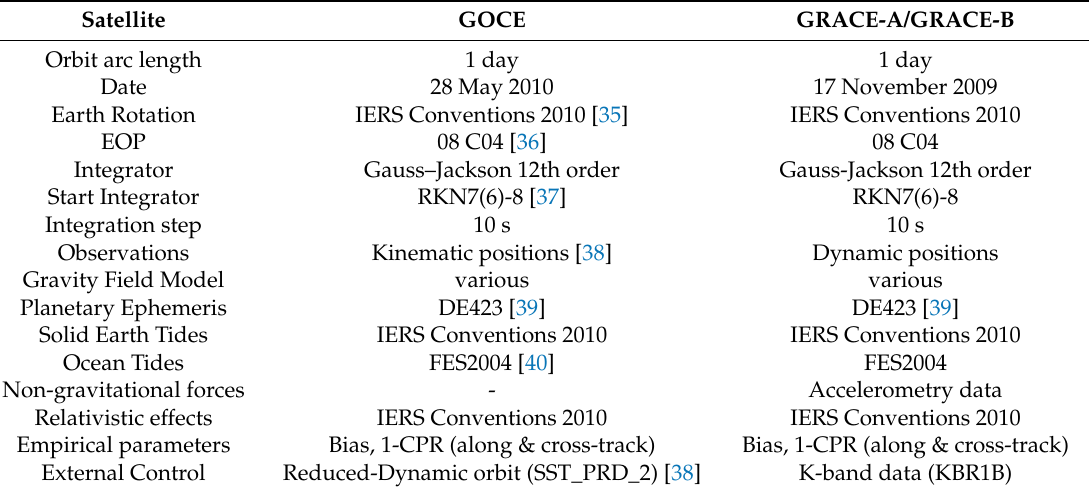
Table 1. Orbit parameterization. Summary of dynamics models and